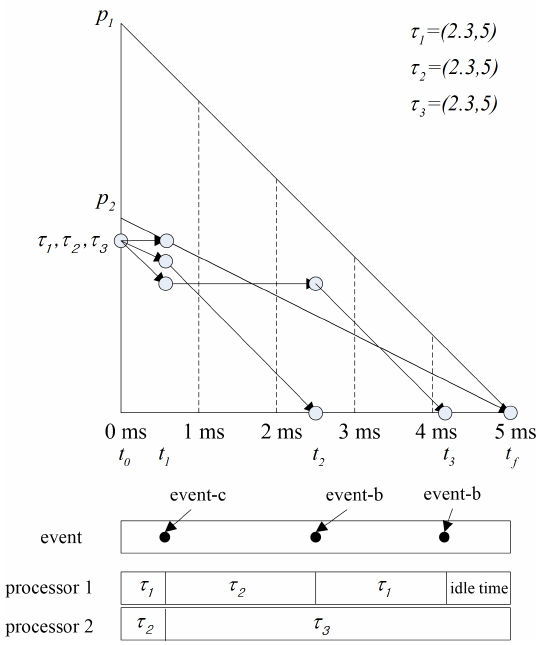
Figure 2. A scheduling example in the 1st T-Ler